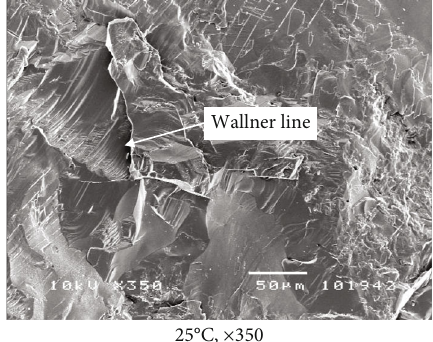
Figure 12: Wallner line.